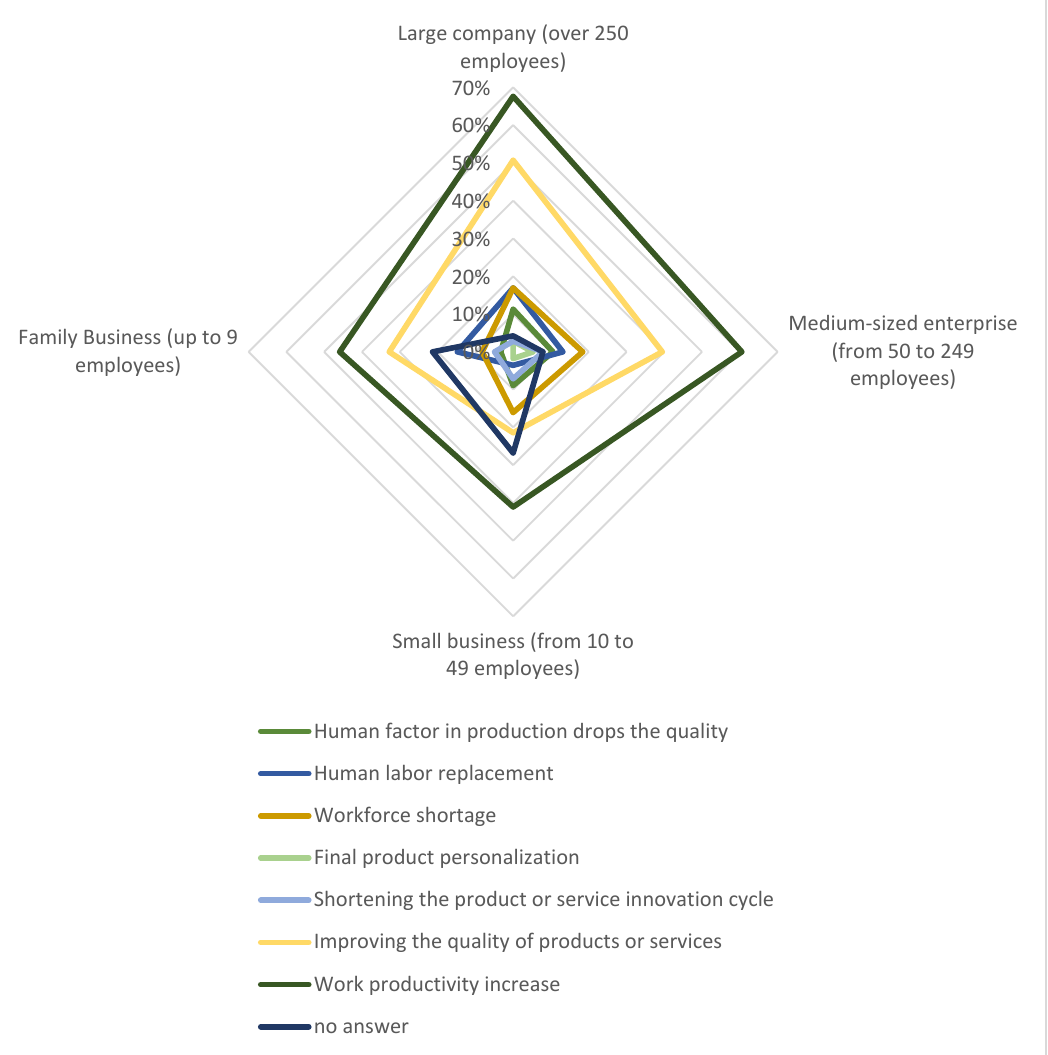
Figure 5. Reasons to implement the Industry 4.0 concept in enterprises by size of enterprise.